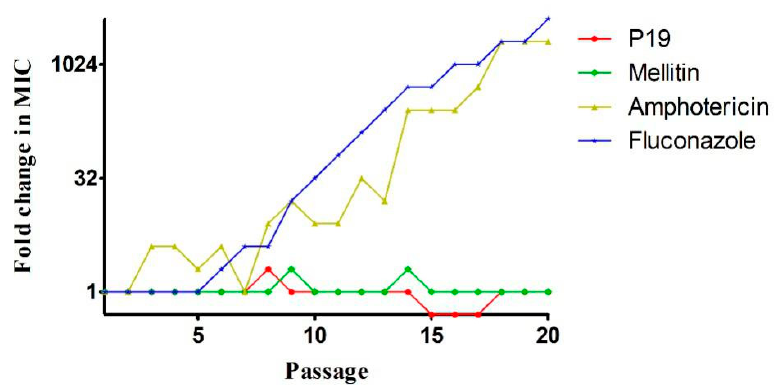
195 195 198 199